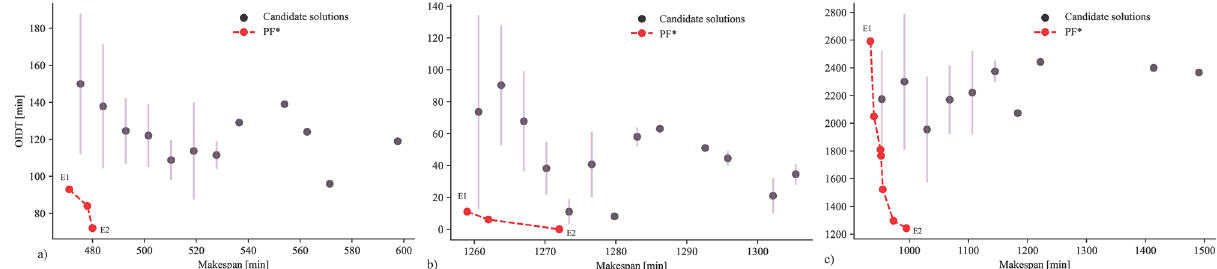
Figure 8. Binned scatter plot of quality indicators representing candidate solutions obtained by five algorithms for instances: ( a ) BK15, ( b ) BK40 and ( c ) BK50. Error bars represent the standard deviation of